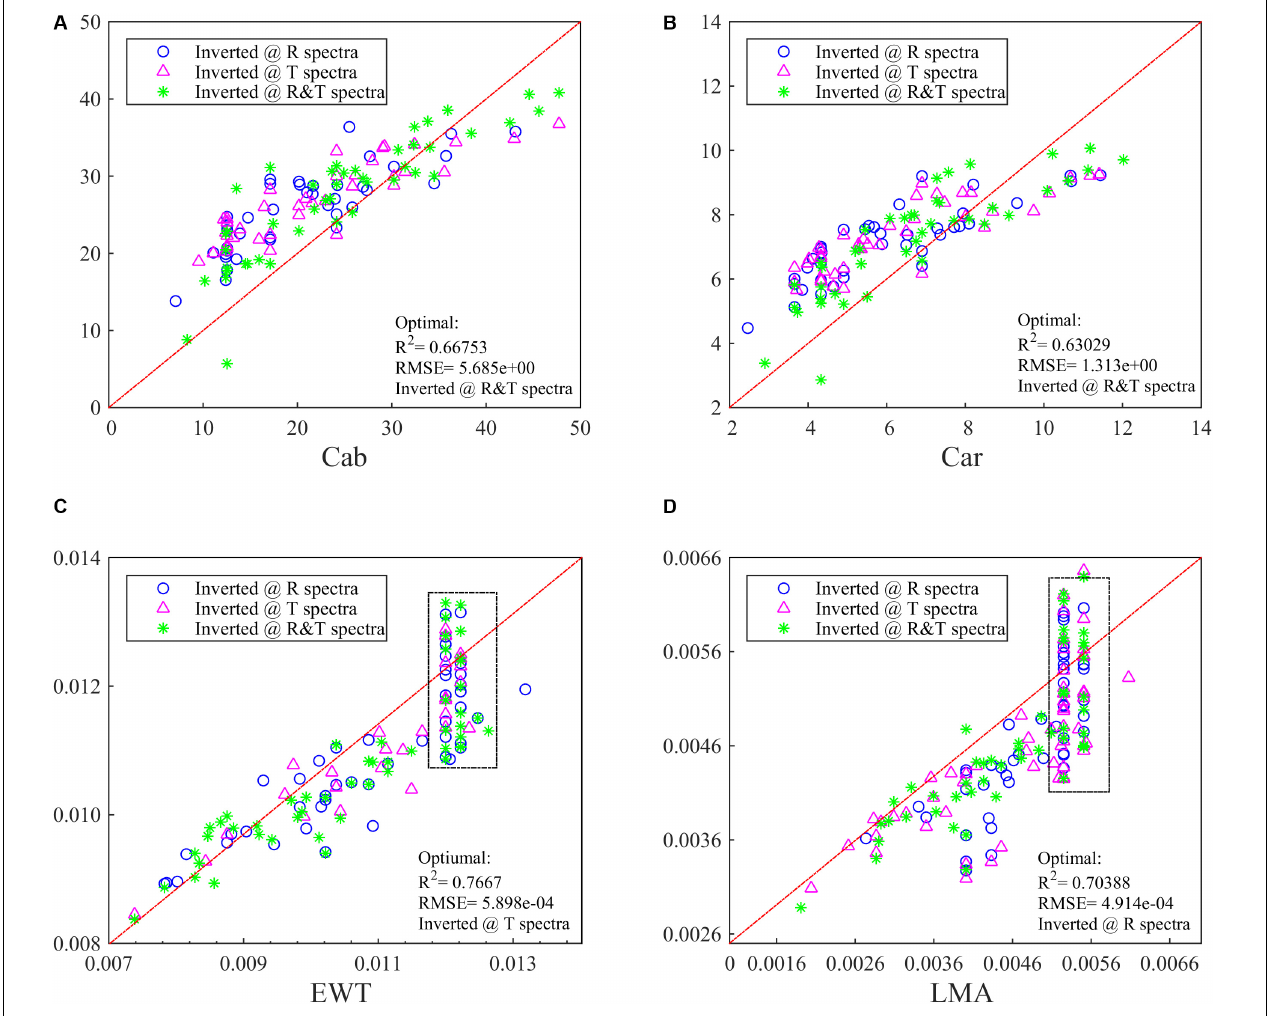
FIGURE 5 | The inversion R 2 for (A) Cab, (B) Car, (C) EWT, and (D) LMA in ANGERS by using PLSR. The optimal R 2 with different spectra has been added in the lower right of the